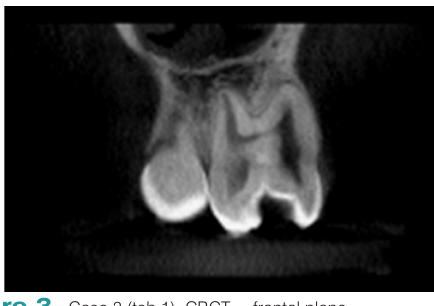
Figure 3. Case 3 (tab.1). CBCT – frontal plane .